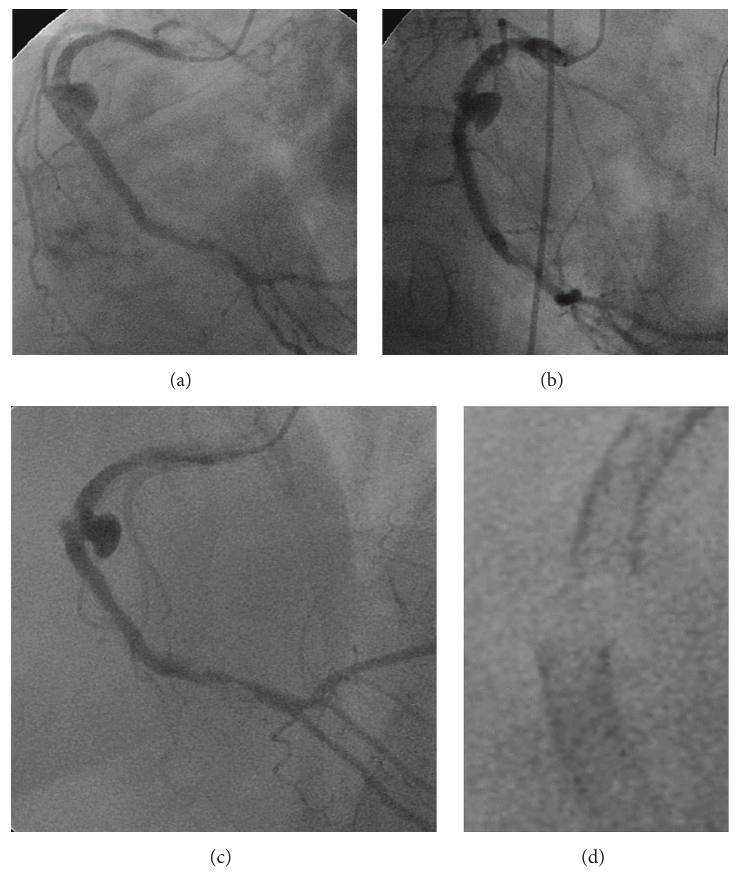
Figure 4: Follow-up coronary angiography showing pseudoaneurysm formation. Left anterior oblique (LAO) view (a), right anterior oblique view (b), and LAO-cranial view (c). (d) X-ray fluorography showing complete stent